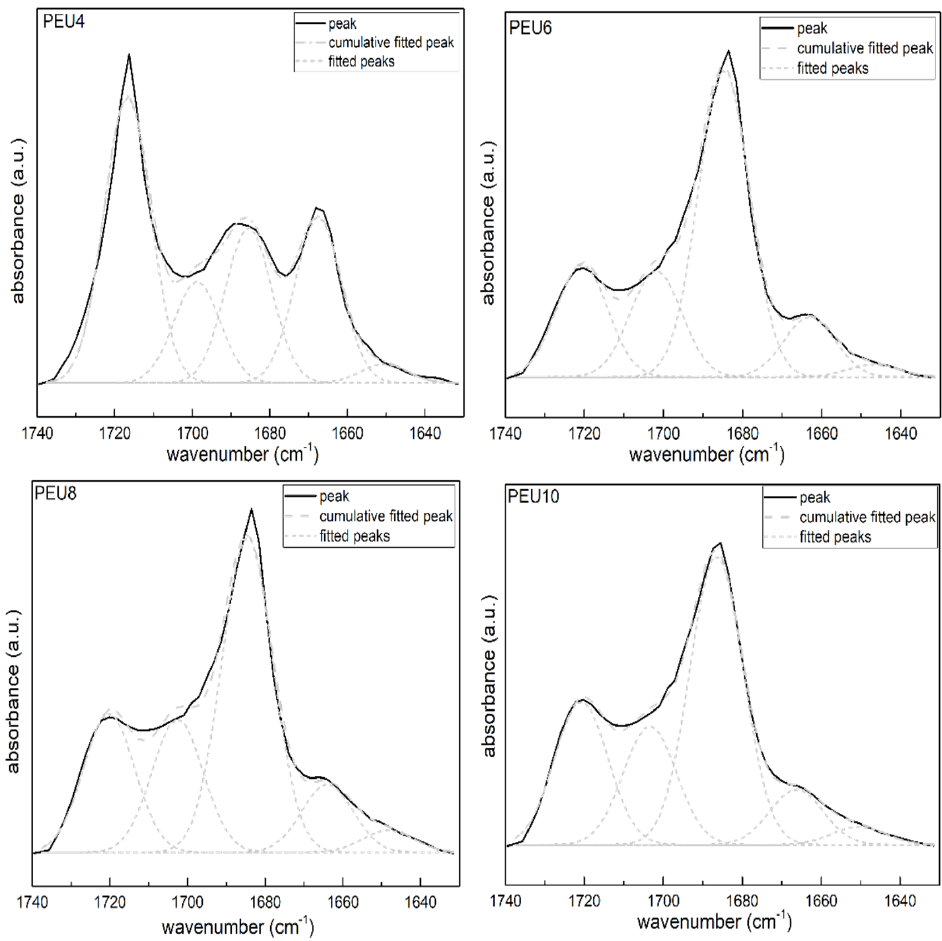
Figure 5. Infrared carbonyl region split peak fit of PEU. Table 2. PEU infrared carbonyl region fitting peak attributions and proportions.